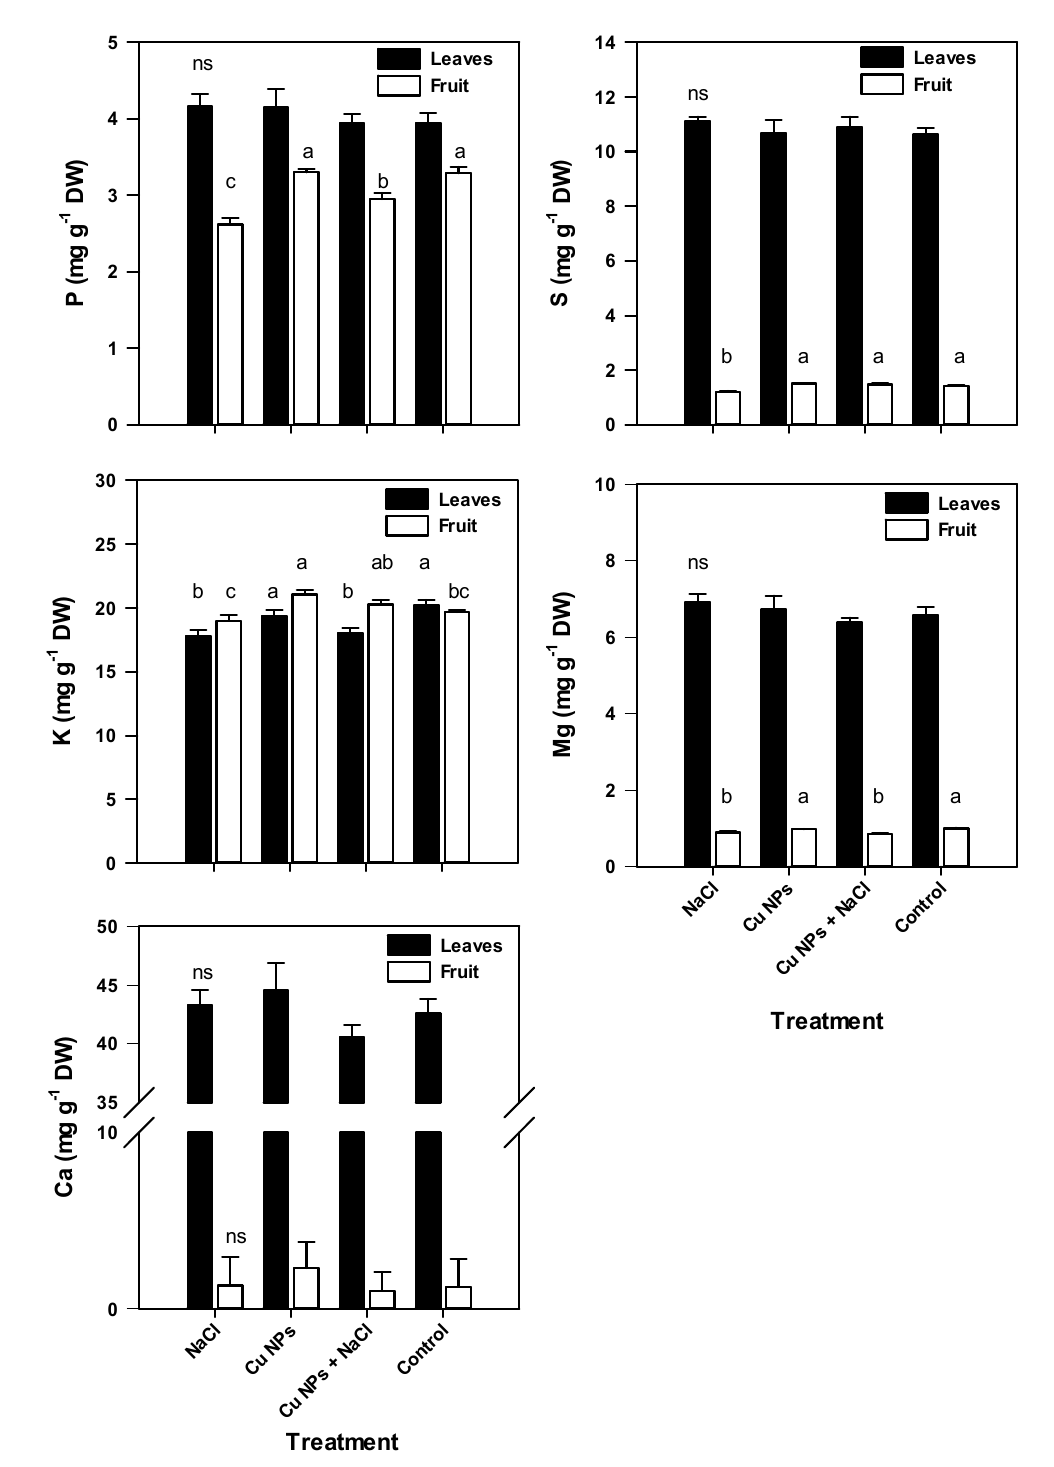
Figure 1. Macronutrient content in leaves and fruits of tomato plants under saline stress and foliar application of Cu NPs. All data are the mean of six replicates ± standard error. Different letters indicate significant differences between treatments according to Fisher’s Least Significant Difference ( p ≤ 0.05); ns—not significant.